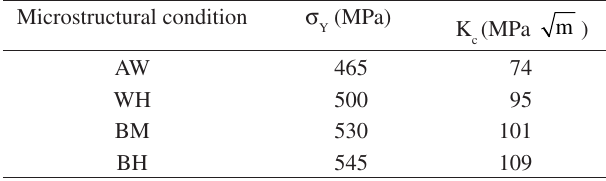
Table 1. Materials properties according to the microstructural